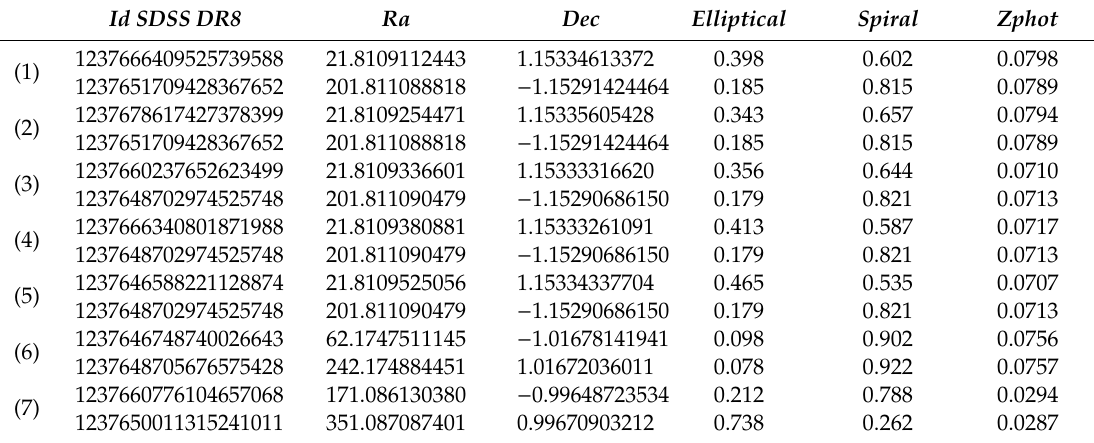
Table 6. Pairs of galaxies for the e ff ect of cosmic mirror from catalog [41]. Id SDSS DR8—objID identification number in the Sloan Digital Sky Survey. Accuracy is of 0.001 ◦ for ra and dec and 0.001 for zphot .